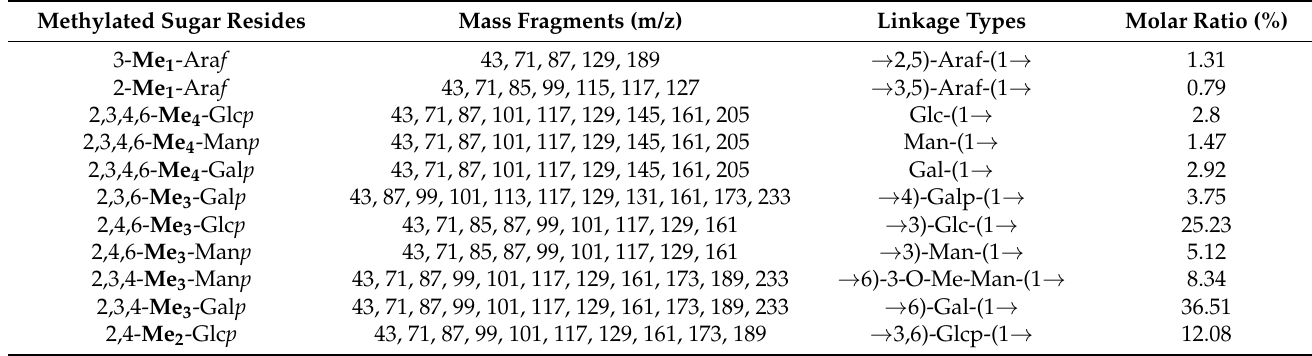
Table 2. Methylation analysis and mode of linkage of